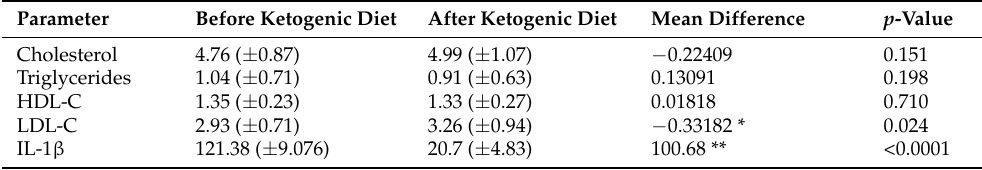
Table 4. Changes in blood lipids (mmol/L) and serum levels of IL-1 β (ng/mL) of participants ( n = 23) before and after intake of the ketogenic